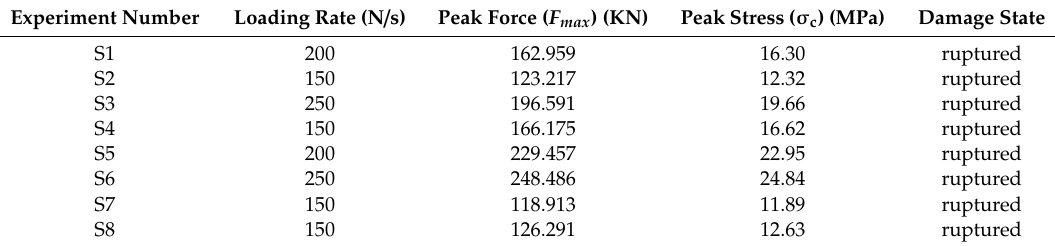
Table 3. Experimental scheme and damage of cement